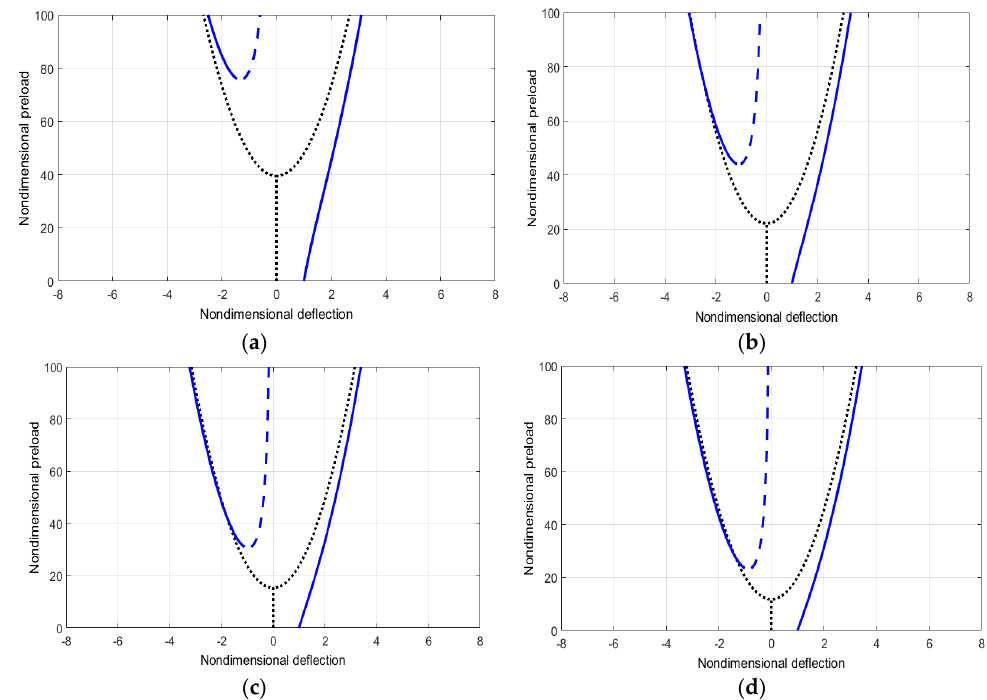
Figure 8. Variation of the static deflection with the pre-load at 𝑎 = 1 and 𝛼 = 3.434 . ( a ) 𝜇̅ = 0.0; ( b ) 𝜇̅ = 0.02; ( c ) 𝜇̅ = 0.04; ( d ) 𝜇̅ = 0.06.